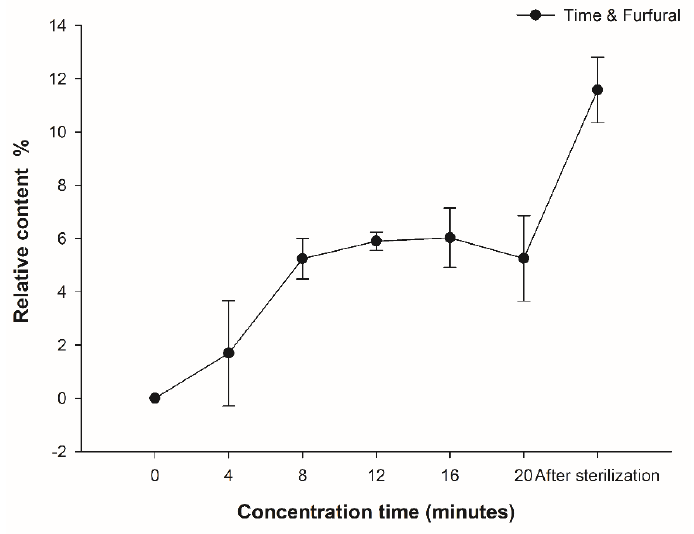
Figure 5. The variation of furfural content during different concentration times.